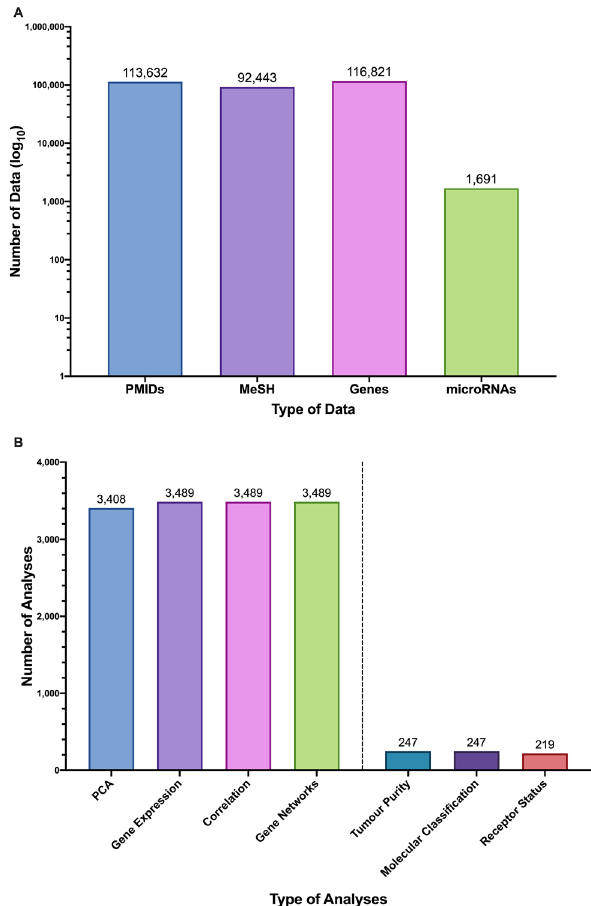
Figure 2. Statistical report of total number of data ( A ) and analyses ( B ) stored in MAP. Bioinformatics analyses have been separated in general (left) and cancer-specific